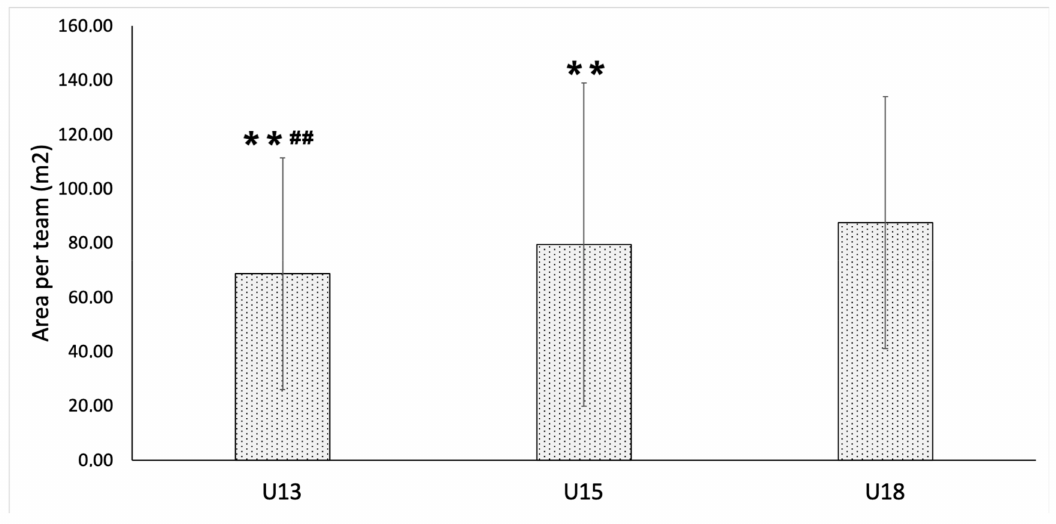
Figure 1. Area occupied by players of each team during the 4 vs. 4 small-sided game (SSG) plus goalkeepers according to age-level groups. ** p < 0.001, di ff erences with U18 age-level group; ## p < 0.001, di ff erences with U15 age-level group.